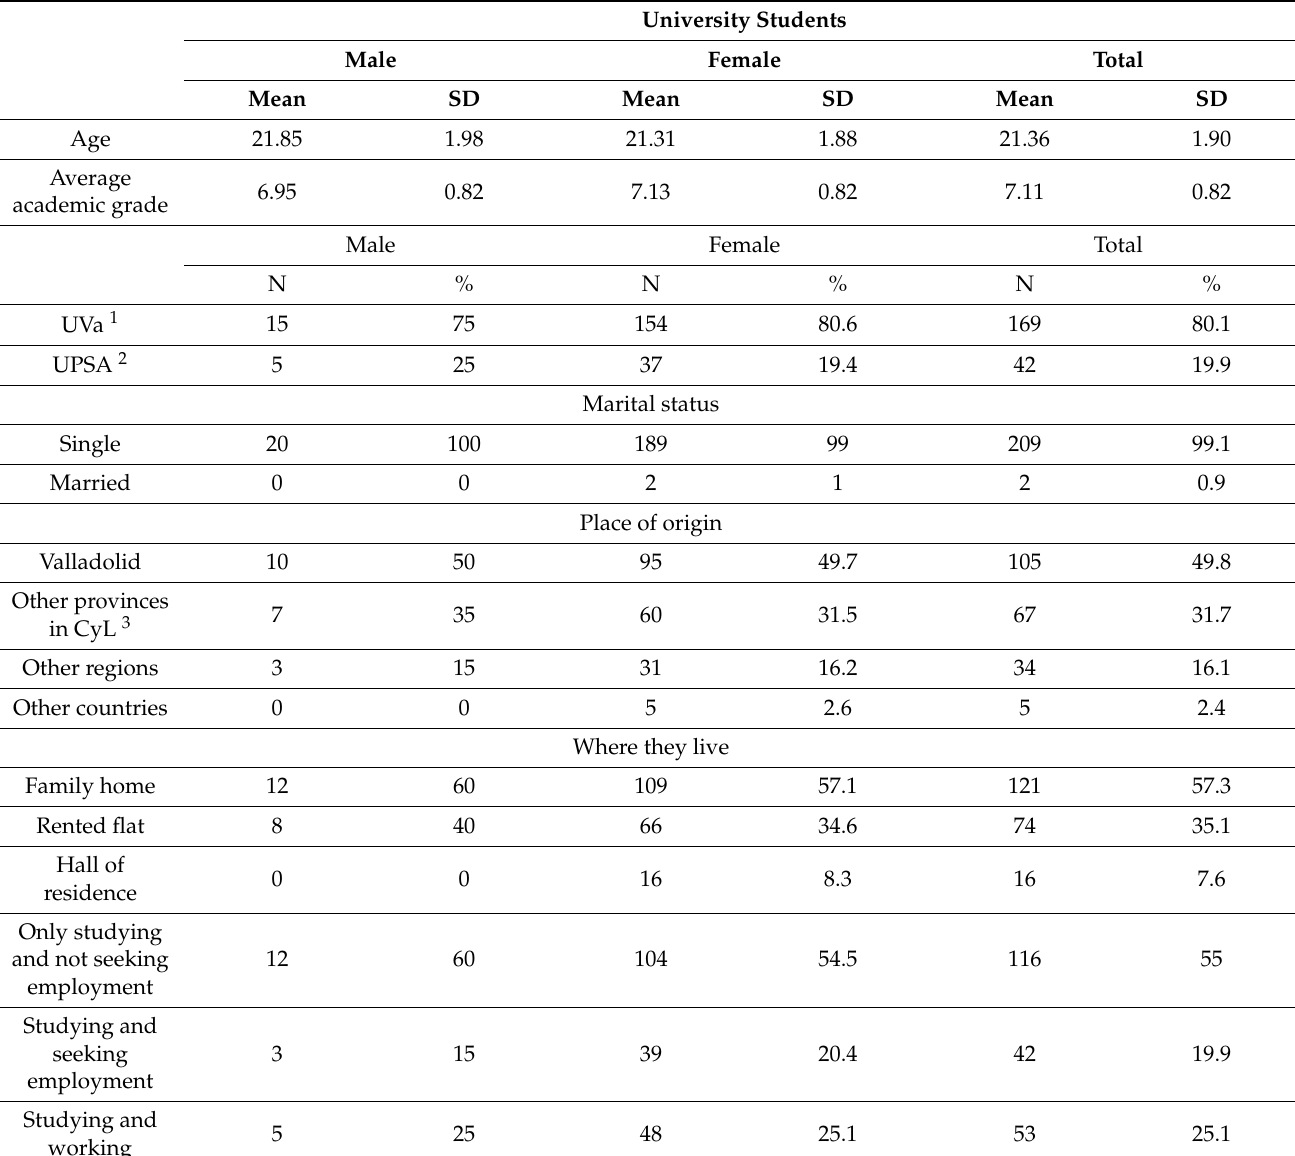
Table 1. Socio-demographic features of university students in Castilla y Le ó